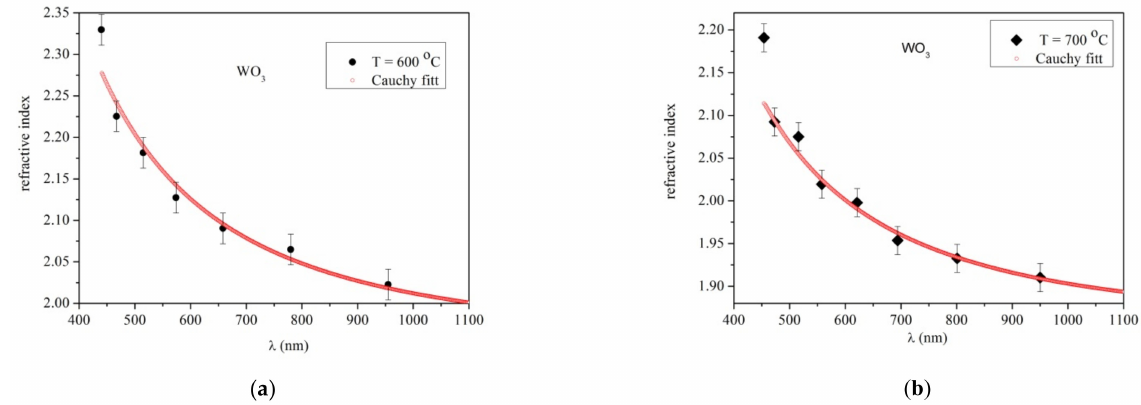
Figure 6. Refractive index plots of pure WO 3 layer grown at 4 h deposition time. ( a ) T = 600 ◦ C; ( b ) T = 700 ◦ C.